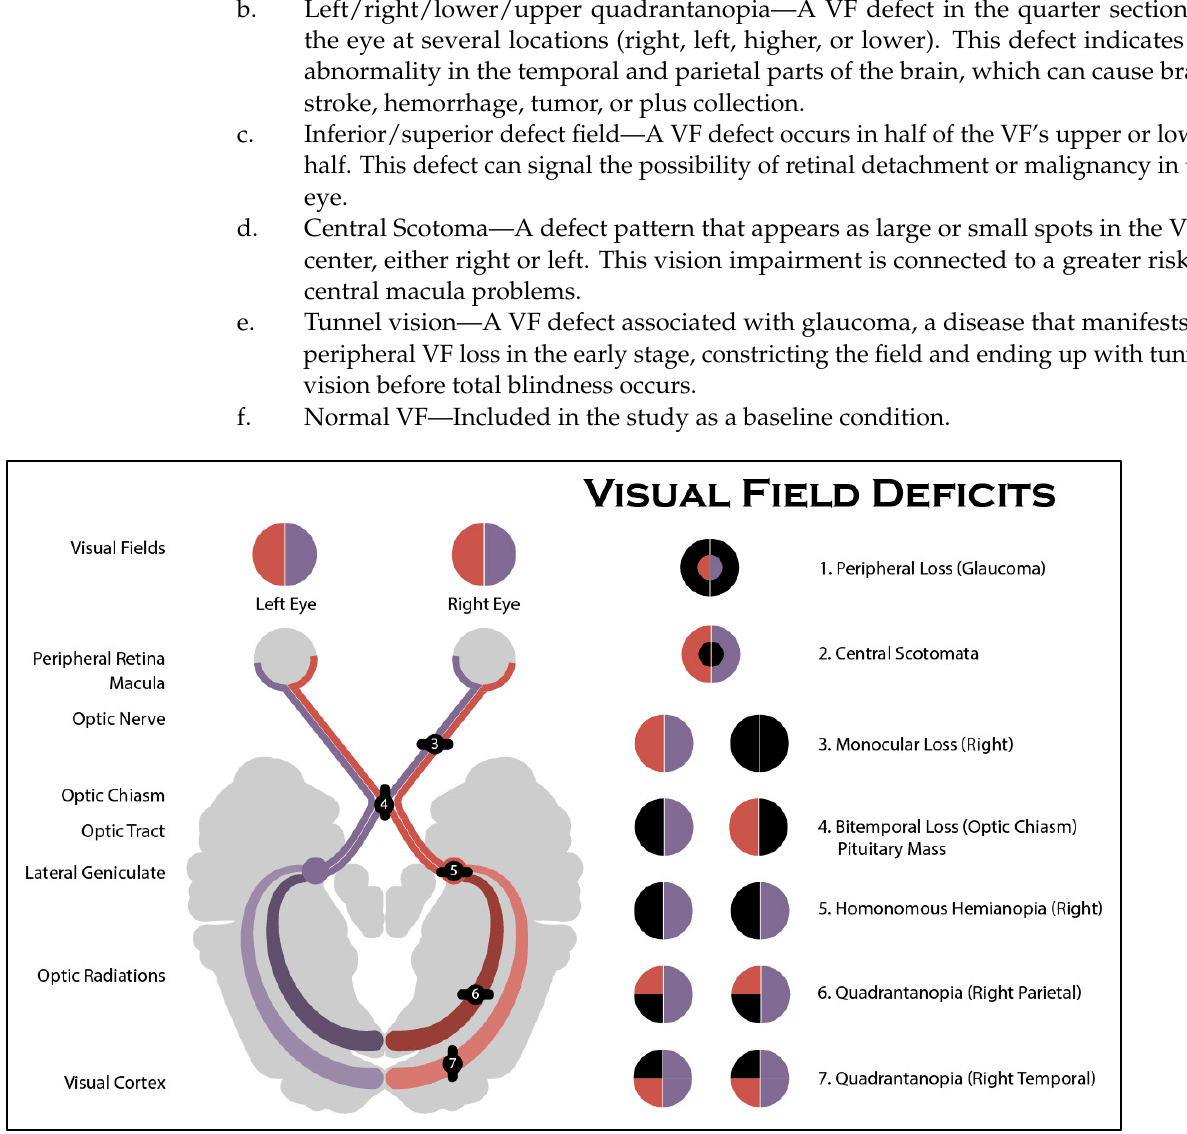
Figure 1. VF Defect Regions